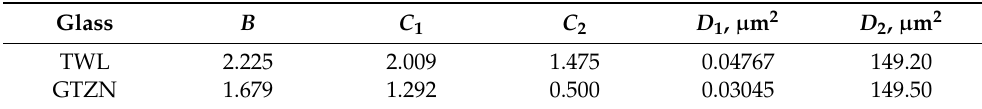
Table 1. Sellmeier constants for 69TeO 2 –23WO 3 –8La 2 O 3 (TWL) and 47.5GeO 2 − 17.5TeO 2 − 20ZnO − 15Na 2 O (GTZN)